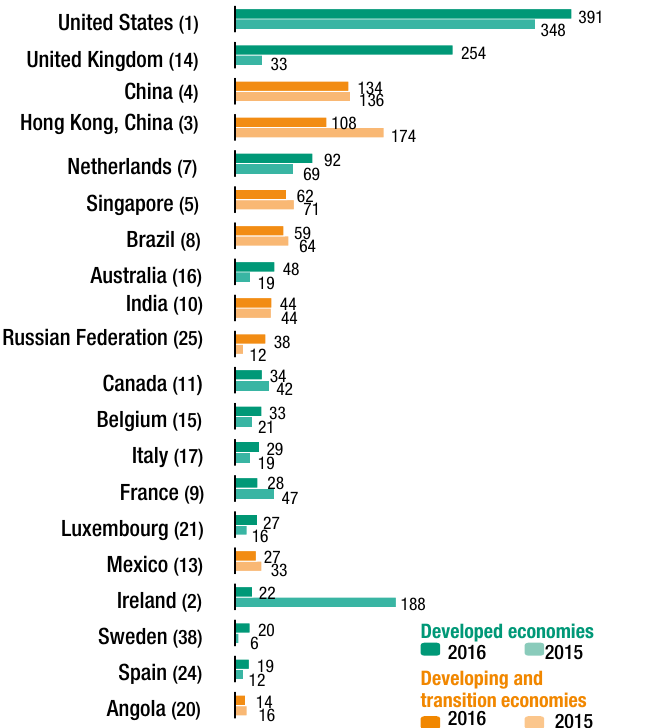
Fig. 1. FDI flows, top 20 economies, 2015 and 2016 ($ Billion). Source: UNCTAD (2017;